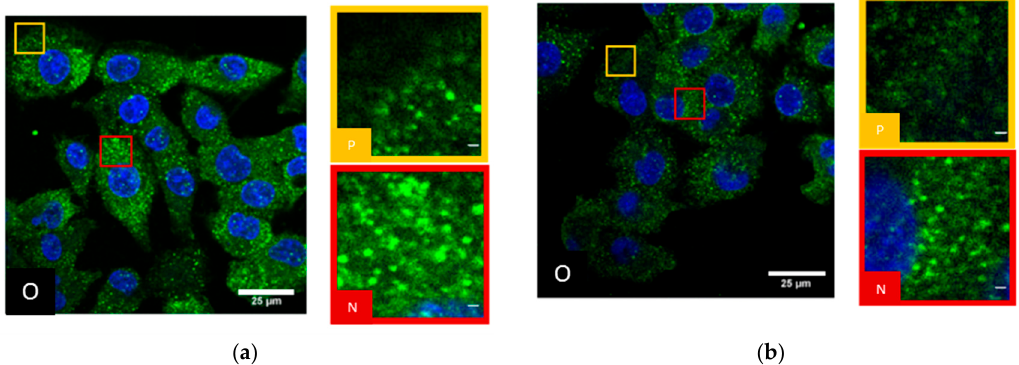
Figure 1. Confocal laser scanning microscopy (CLSM) images of SkBr3 breast cancer cells: ( a ) untreated; ( b ) after 4 Gy irradiation and 50 min recovery; blue: Cell nucleus after Hoechst34580 staining; green: Cx43 specific antibody labelling and Alexa488 staining. (O) Overview with selected peripheral and perinuclear regions. (P) Image section of the periphery of a SkBr3 cell; (N) image section of the perinuclear region of a SkBr3 cell. Scale bar: 1 µm.